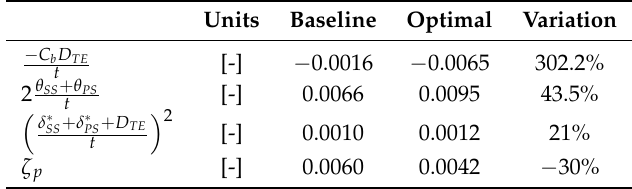
Table 2. Profile loss contribution for the baseline and optimal.